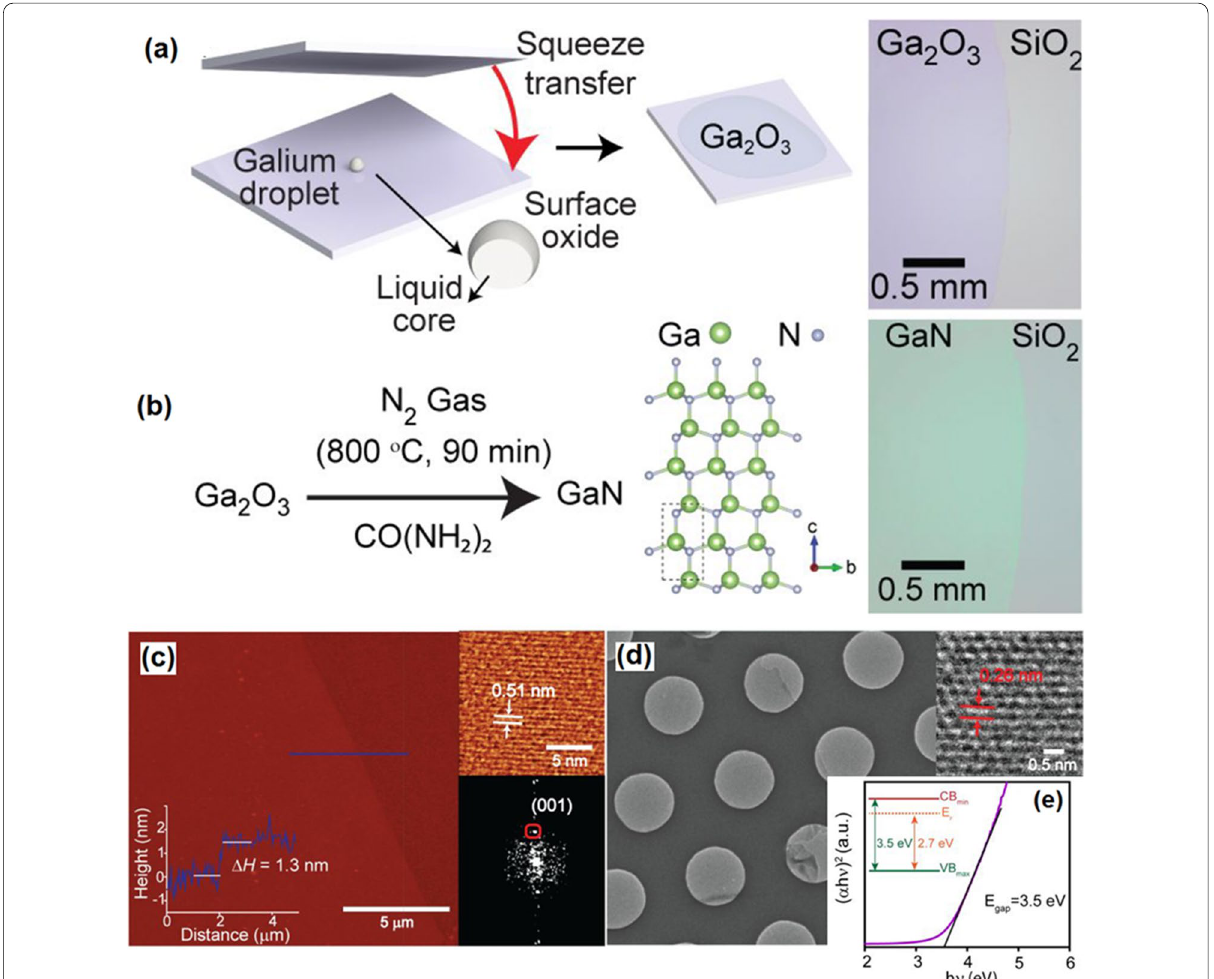
Fig. 12 a Schematic illustration of squeezing of liquid metal galinstan between SiO 2 substrate and b following post-ammonolysis treatment for phase transform of Ga 2 O 3 to GaN film. c The High resolution AFM image of the surface of GaN film. d The HRTEM image of GaN film and e the band gap of measurement of GaN film. Reprinted with permission from